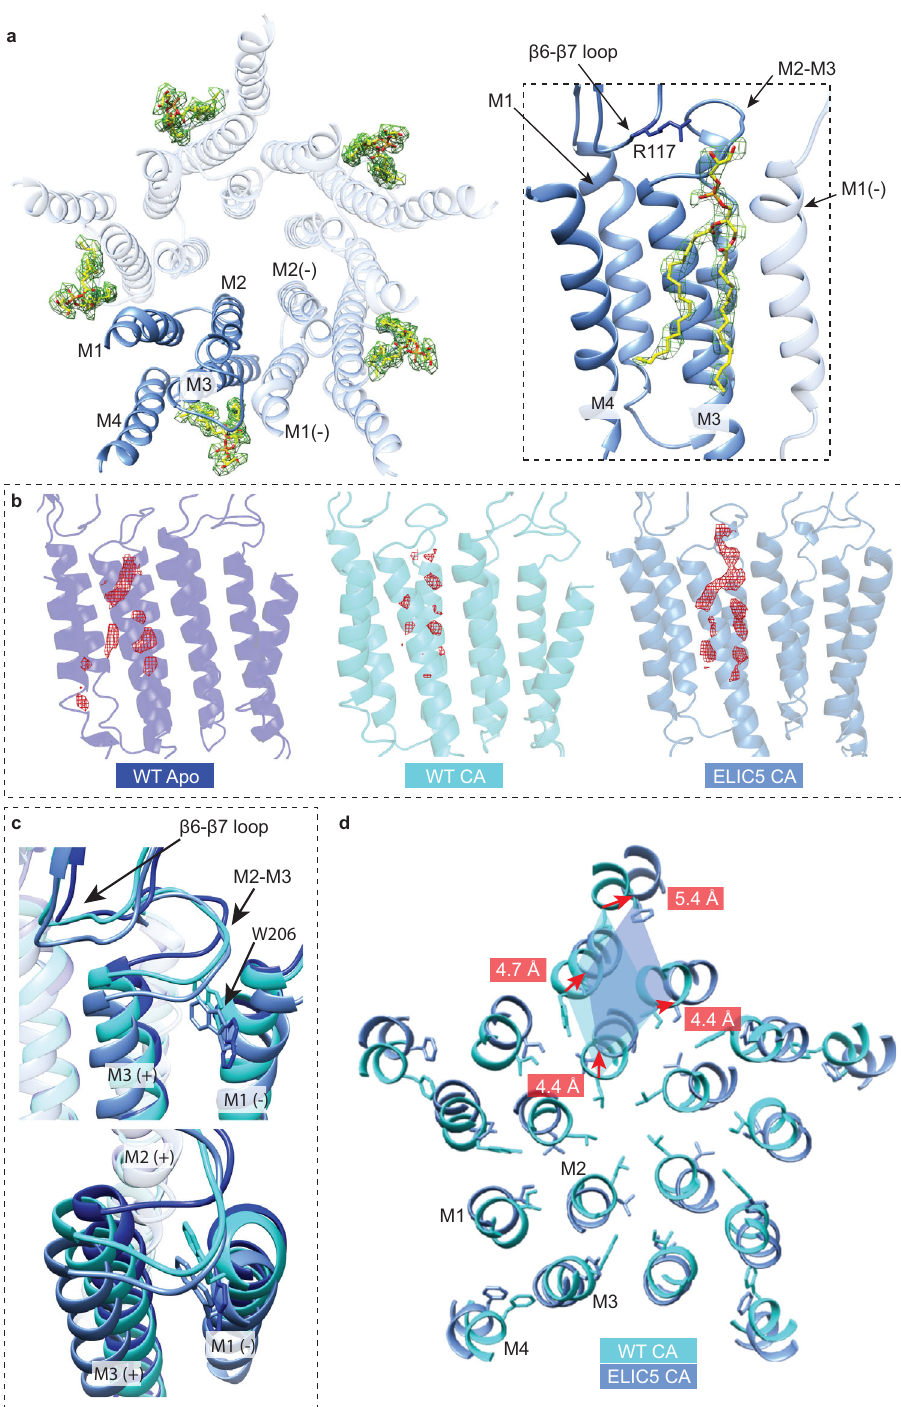
Fig. 3 | Outer lea fl et phospholipid binding site and conformational changes associated with ELIC opening. a Left: Structure of ELIC5 TMD viewed from extracellular side showing bound POPG (yellow) in the density map (green). Right : Sideviewof ELIC5phospholipid binding site showingPOPG (yellow)inthe density map (green). The R117 side chain is shown. b Phospholipid density (red) displayed at σ -levelof3.0fromcryo-EMdensitymapsofWTapo,WTCA,andELIC5CA. c Top : Conformationalchangesinthe β 6- β 7loopandtheM2-M3linkerinWTapo,WTCA